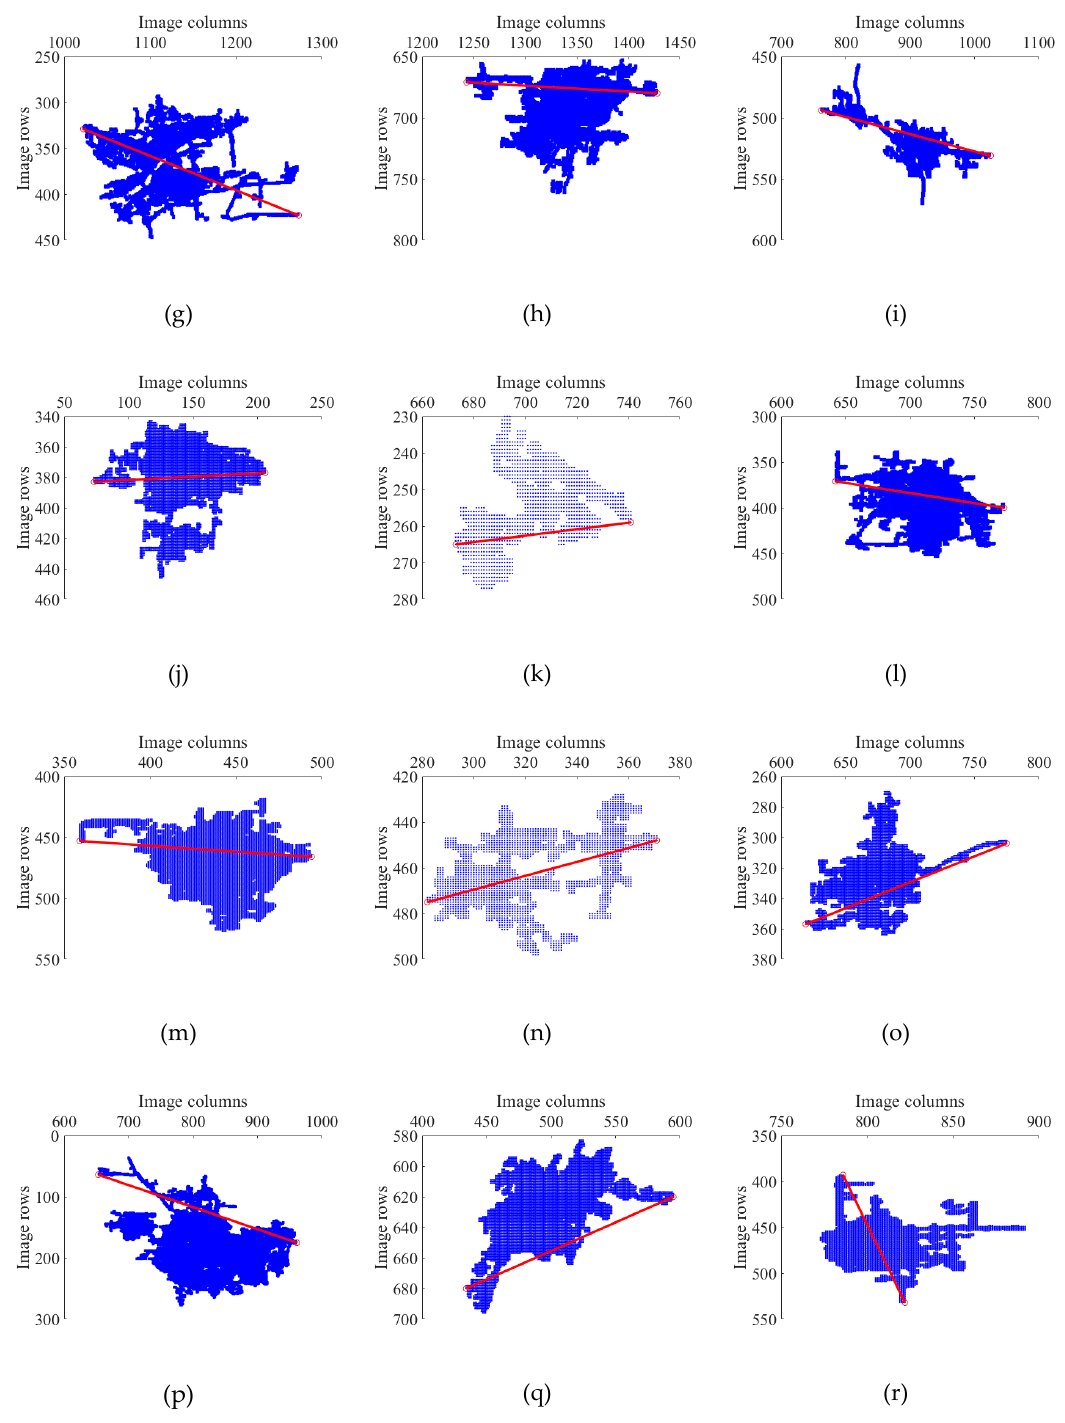
Figure 9. The “width” and “angle” of cities in Henan Province: ( a )Anyang, ( b ) Hebi, ( c ) Jiaozuo, ( d ) Jiyuan, ( e ) Kaifeng, ( f ) Luohe, ( g ) Luoyang, ( h ) Nanyang, ( i ) Pingdingshan, ( j ) Puyang, ( k ) Sanmenxia, ( l ) Shangqiu, ( m ) Xinxiang, ( n ) Xinyang, ( o ) Xuchang, ( p ) Zhengzhou, ( q ) Zhoukou, ( r ) Zhumadian.